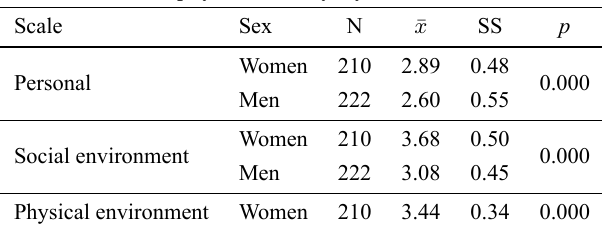
Table 2. T -test analysis of subdimensions of barriers to physical activity, by